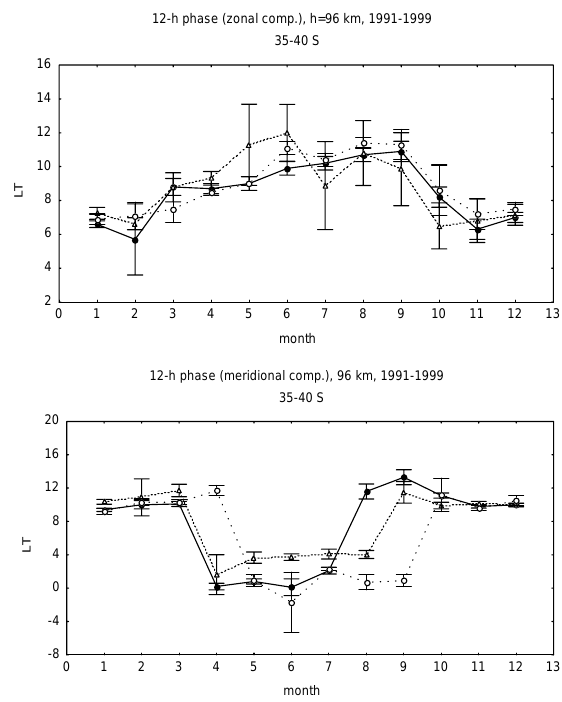
Fig. 11. Same as Fig. 7, except for phase of semidiurnal